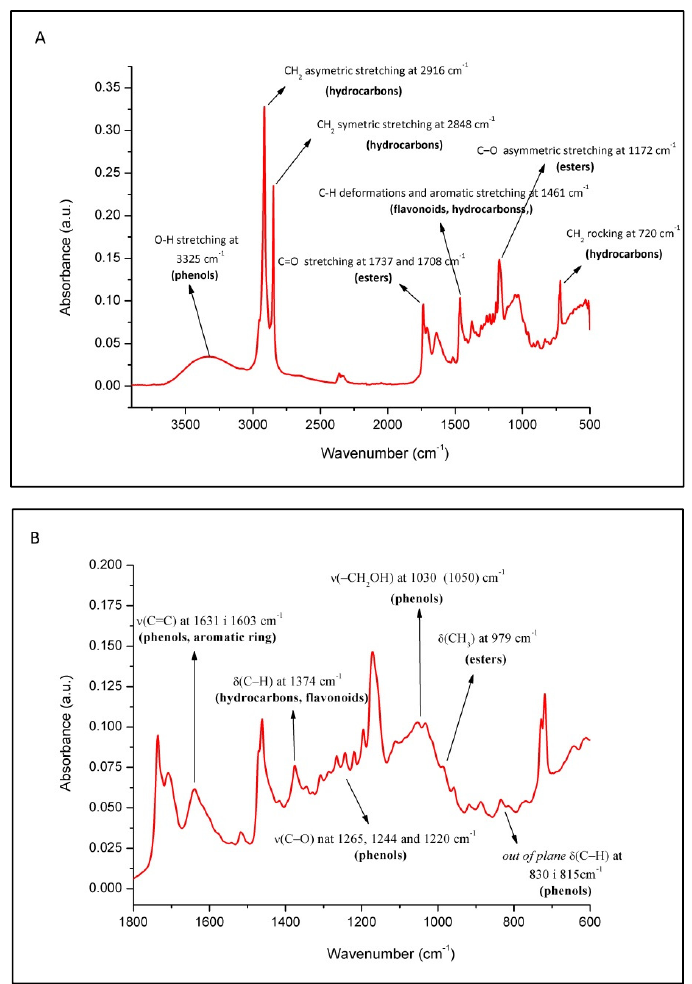
Figure 1. Characteristic FTIR-ATR spectrum of raw propolis (average K3 sample) with assigned underlying molecular vibrations: Spectral region from 3800 to 500 cm − 1 ( A ); fingerprint region 1800–600 cm − 1 ( B ).